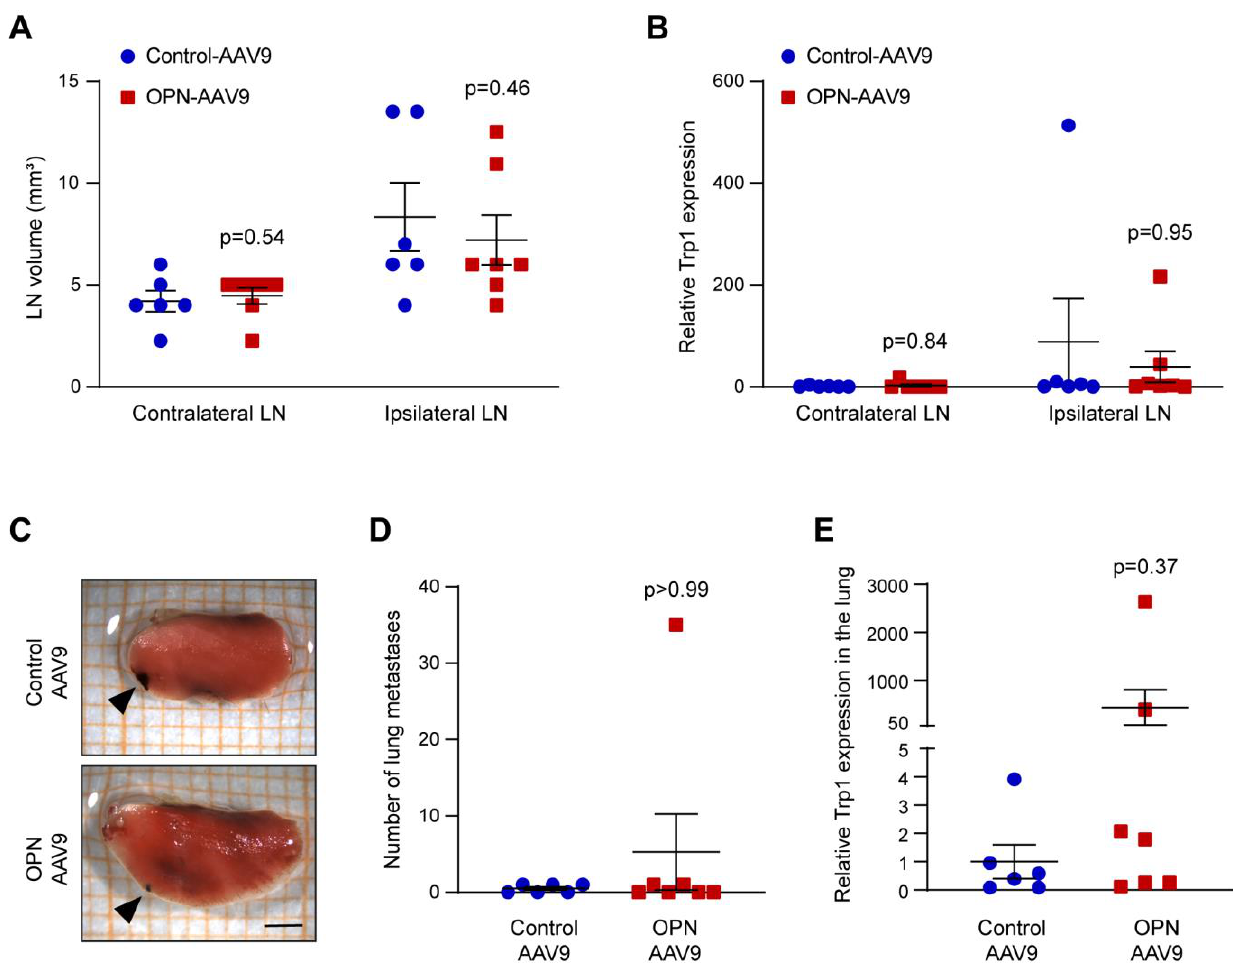
Figure 5. An increase in cOPN does not enhance melanoma lymph node and lung metastasis. Mice were transduced with control-AAV9 and OPN-AAV9 at 5 × 10 10 viral particles, then injected with B16F10 melanoma cells s.c. At the end point, axillary lymph nodes were analysed. ( A ) Volume of contralateral and ipsilateral axillary lymph nodes (LN). ( B ) Expression of the melanoma marker Trp1 in contralateral and ipsilateral axillary lymph nodes measured by qPCR. ( C ) Representative images of B16F10 metastatic nodules in the lungs (indicated by black arrowheads). Scale bar: 2 mm. ( D ) Number of metastatic nodules in the lungs. ( E ) Expression of the melanoma marker Trp1 in the lungs. Control and OPN groups were compared using the Mann Whitney test; n = 6 for Control-AAV9 and n = 7 for OPN-AAV9.